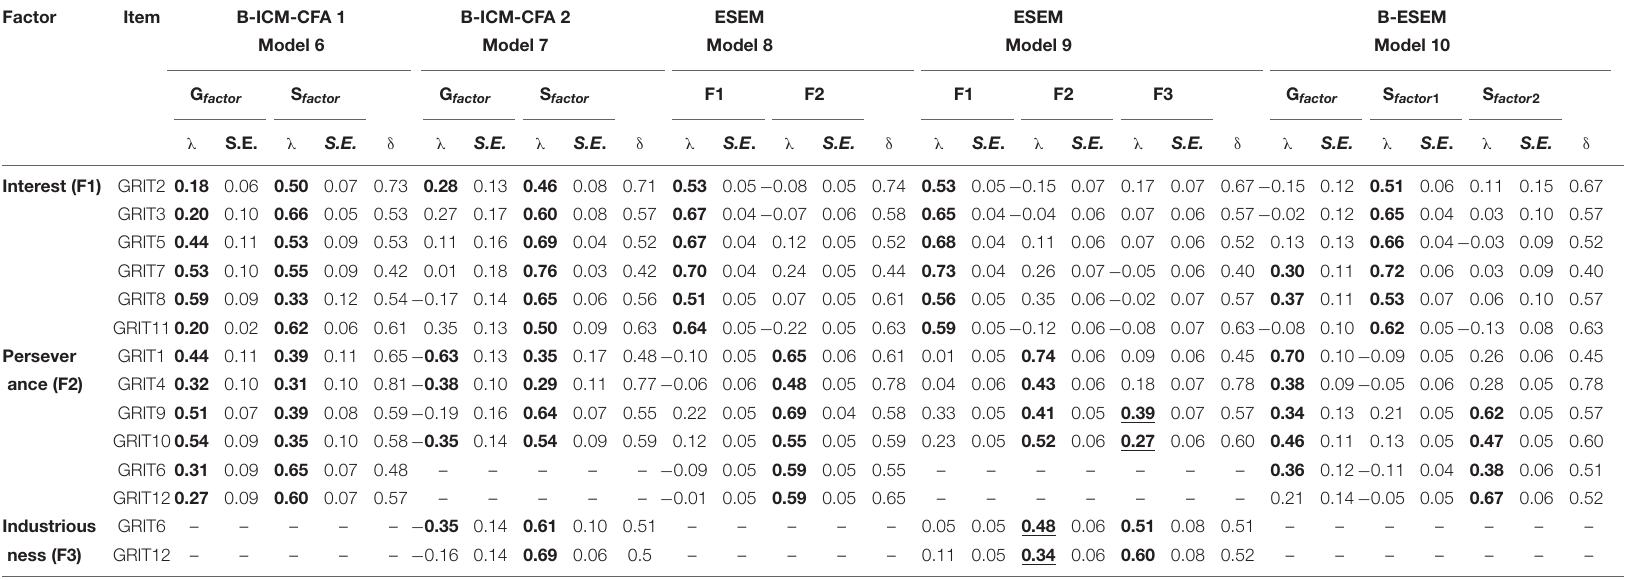
Bold items loaded significantly (p < 0.05); Underlined items indicate cross-loading items; S.E., standard